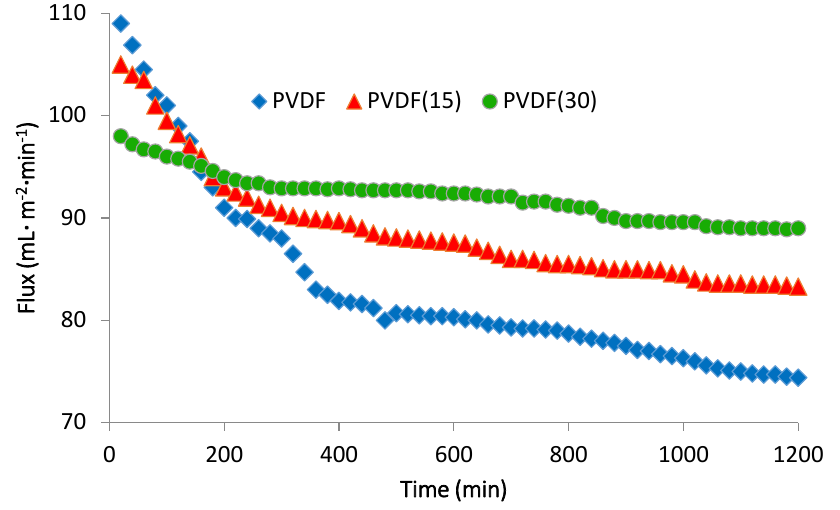
Figure 11. The flux variation of pure PVDF, PVDF15, and PVDF30 after 20 h filtration.